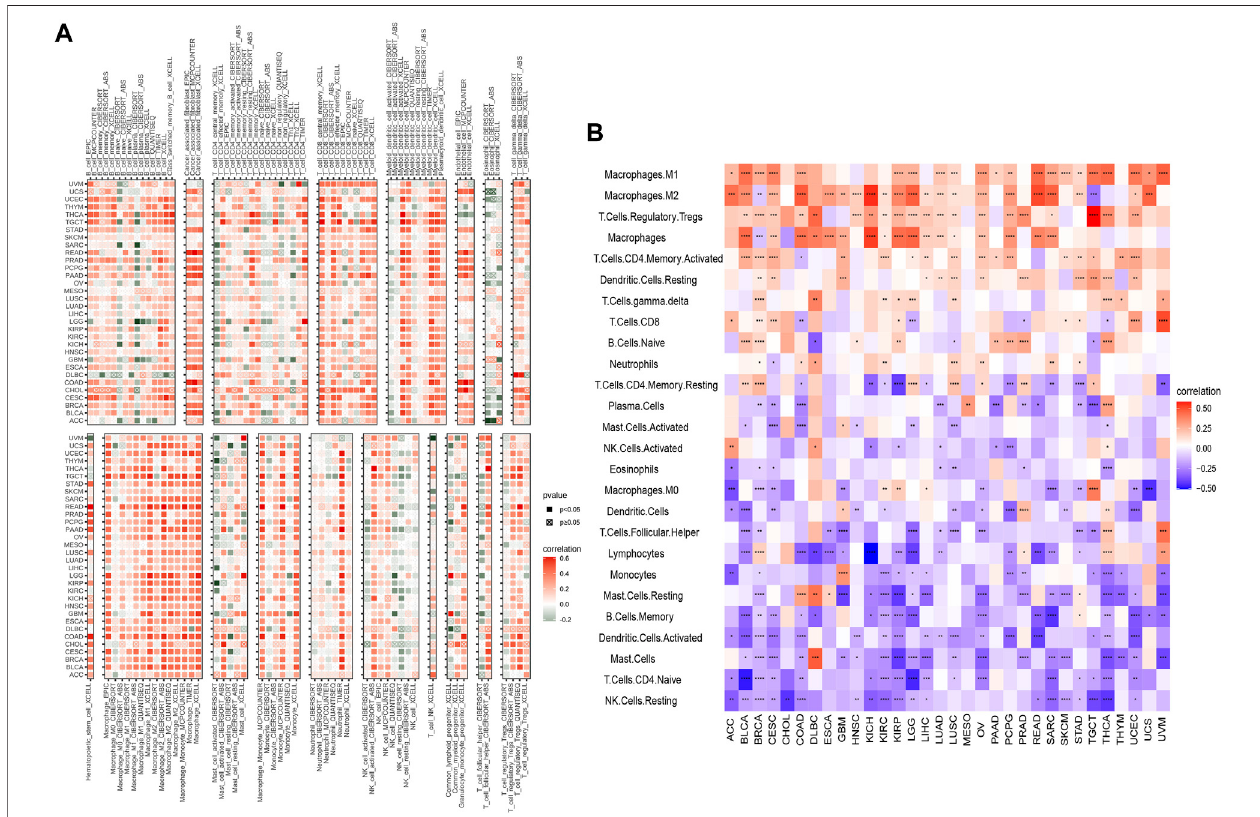
FIGURE 12 | Correlation between LY96 expression and immune in fi ltrated cells. (A,B) Correlation between LY96 expression and immune in fi ltrated cells using TIMER2 data (A) and the CIBERSORT algorithm (B)